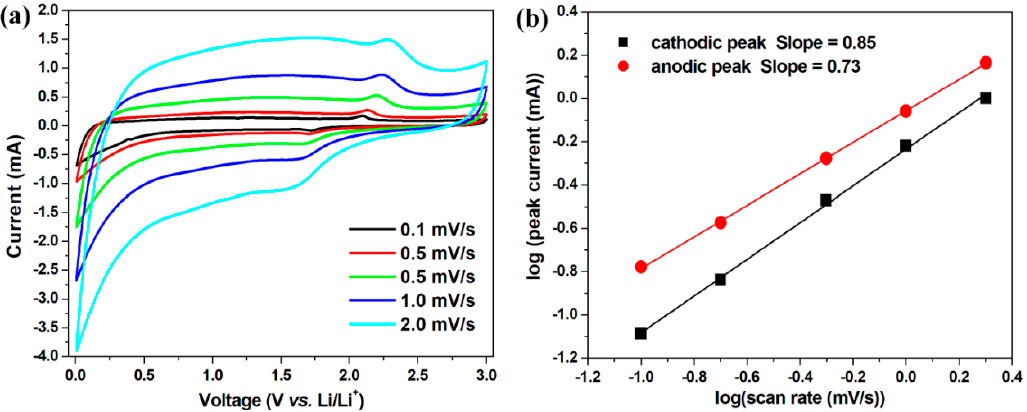
Figure 5. ( a ) CV curves of TSC electrode at different scan rates and ( b ) the corresponding log-log plots of the cathodic/anodic peak currents versus the scan rates.